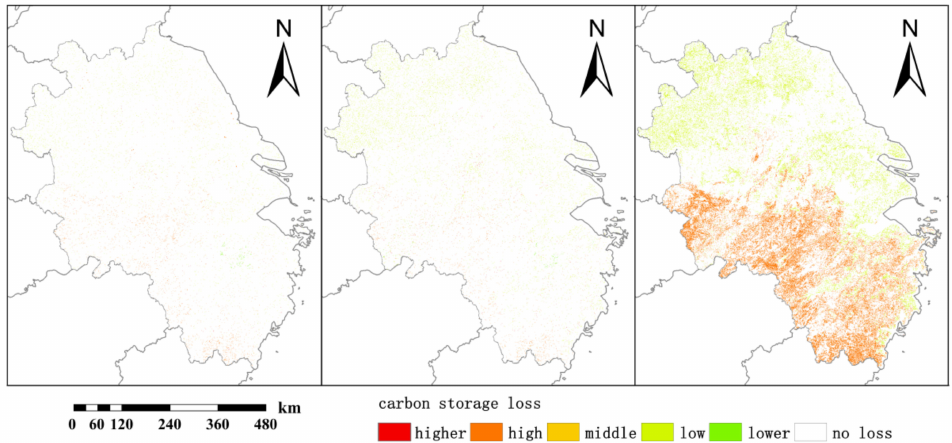
Figure 11. Carbon storage loss during 2020–2060 under different